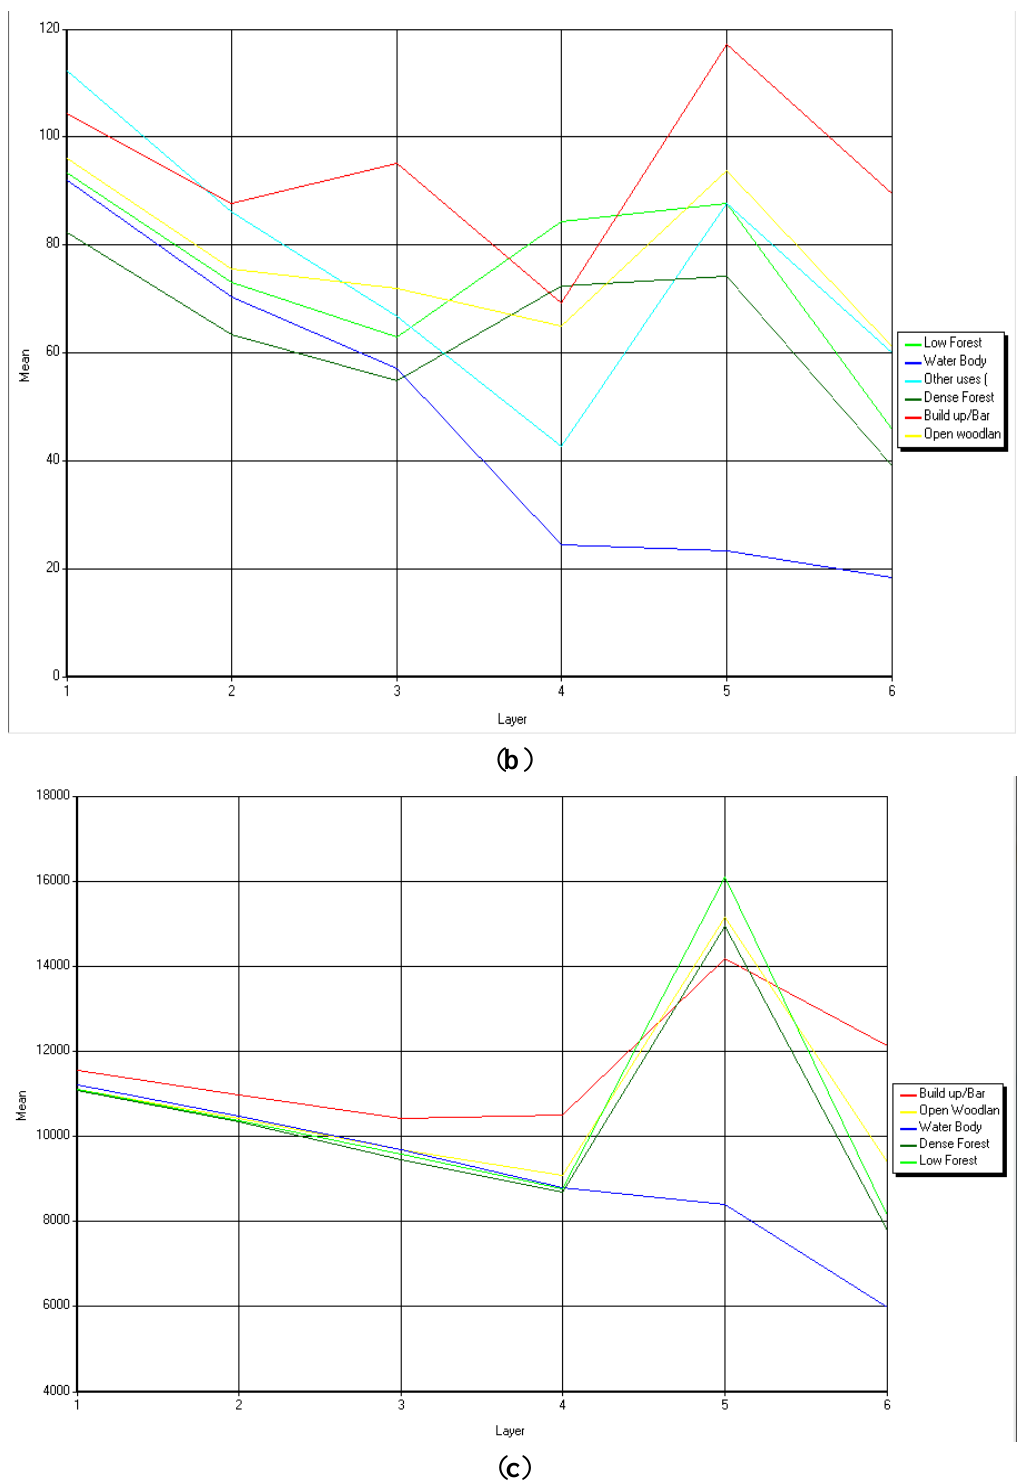
Figure 1. Spectoral Separability Plots for LULC Classes for ( a ) 1986 LULC; ( b ) 2010 LULC; ( c ) 2014